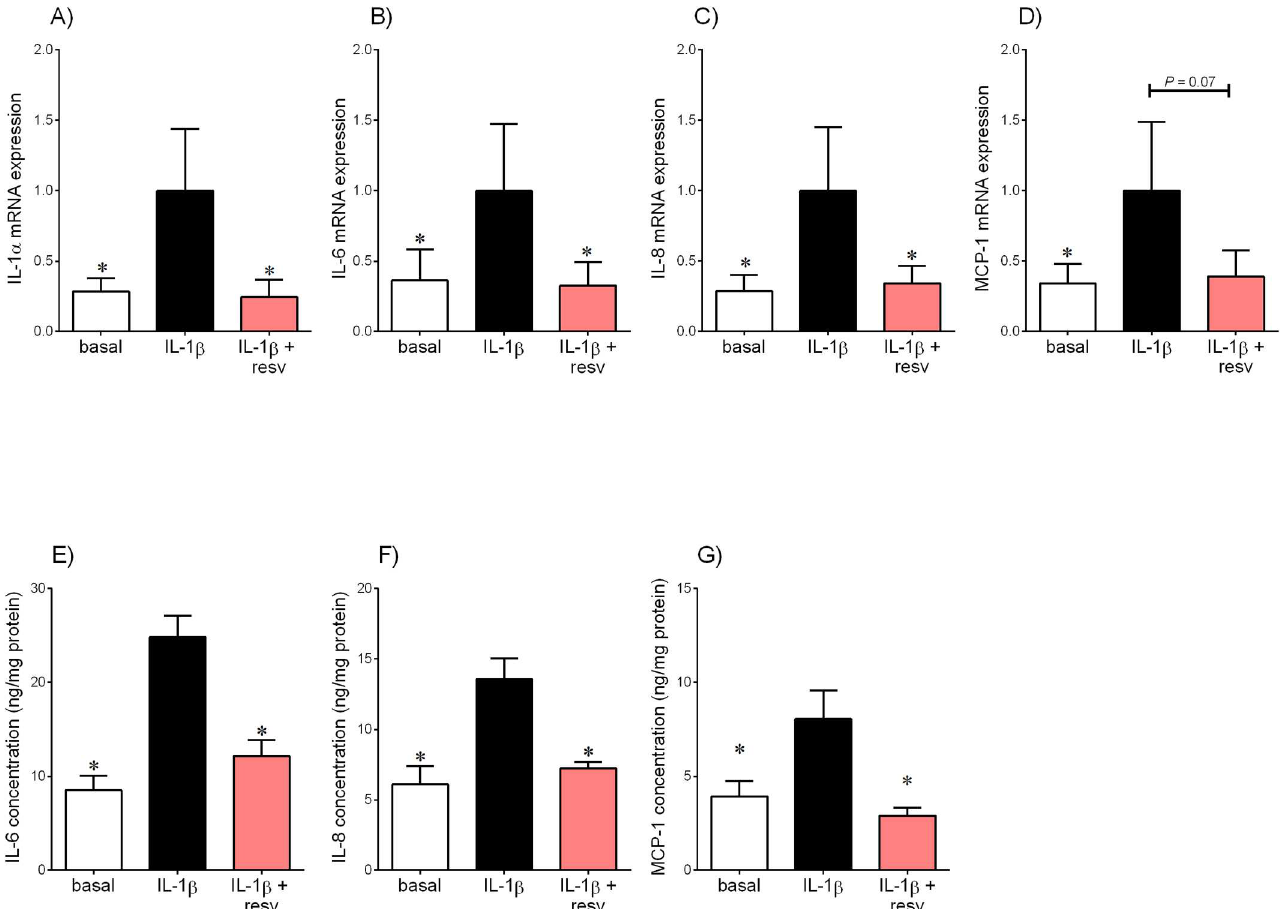
Fig 2. Effect of resveratrol on IL-1 β -induced pro-inflammatory cytokines and chemokines in placenta. Human placenta was incubatedwith 5 ng/ml IL-1 β in the absenceor presence of 200 μ M resveratrol (resv) for 20 h (n = 6 patients). (A-D) IL-1 α , IL-6, IL-8 and MCP-1 mRNA expression was analysedby qRT-PCR and the fold changewas calculatedrelative to IL-1 β . (E-G) The incubation medium was assayed for concentration of IL-6, IL-8 and MCP-1 release by ELISA. All data are displayedas mean ± SEM. * P < 0.05vs. IL-1 β